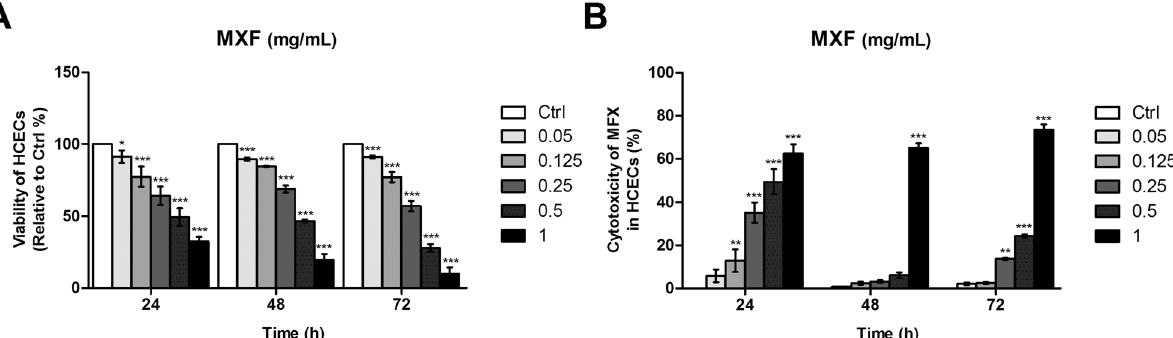
Figure 1. HCECs viability and toxicity assay after MXF exposure. Both cellular viability and membrane toxicity (LDH release) were measured after incubation with MXF at various concentrations (0 to 1.0 mg/ml). ( A ) MXF induced significant HCECs cytotoxicity even at 0.05 mg/ml concentration, measured after 24 h, 48 h, and 72 h of exposure. The highest MXF concentration of 1 mg/ml induced almost 85% cell death after 72 h of exposure. ( B ) The LDH release from HCECs showed a dose-dependent increase after 24 h, 48 h, and 72 h of exposure to MXF. The triplicates of each treatment group were used in each independent experiment. The values were given as the mean ± SEM from three independent experiments. (* p < 0.05; ** p < 0.01; *** p < 0.001). Ctrl: no treatment